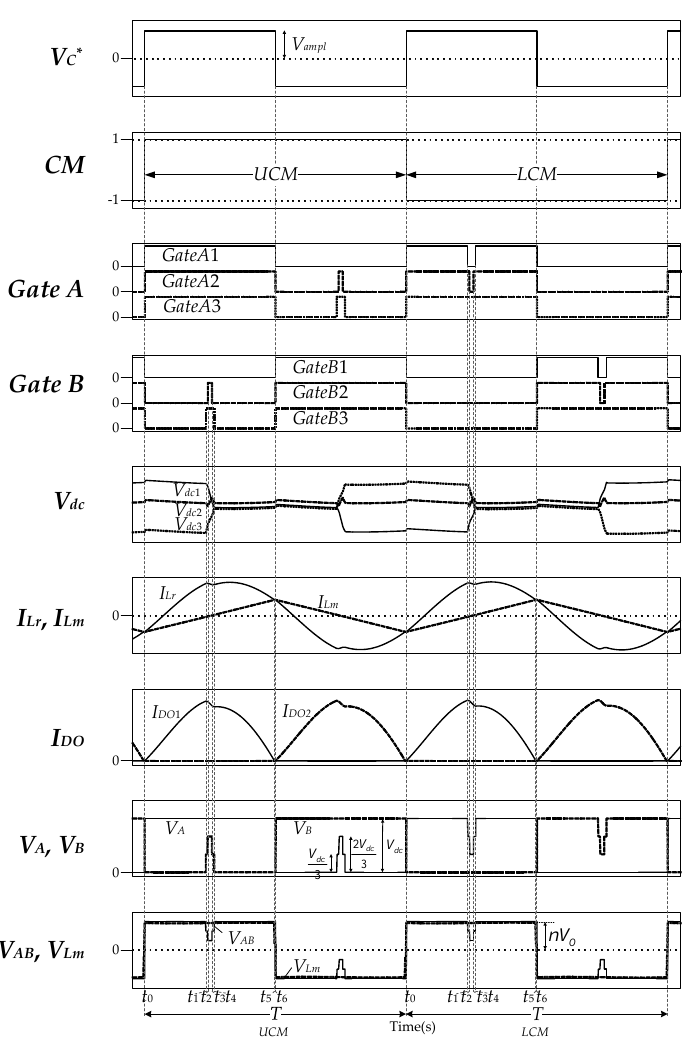
Figure 9. Operating mode analysis of the proposed converter.